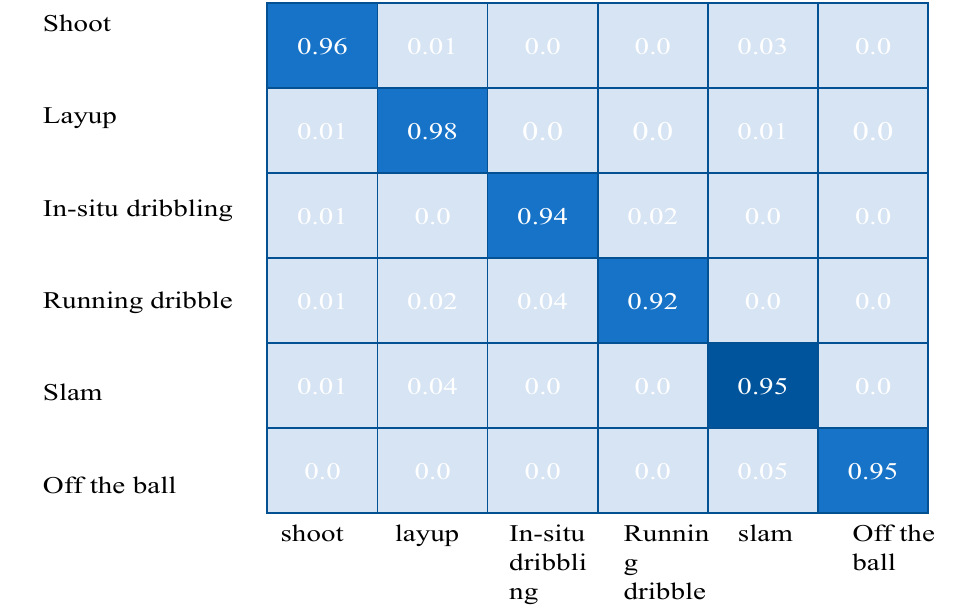
Figure 9. Ball-based action recognition confusion matrix.